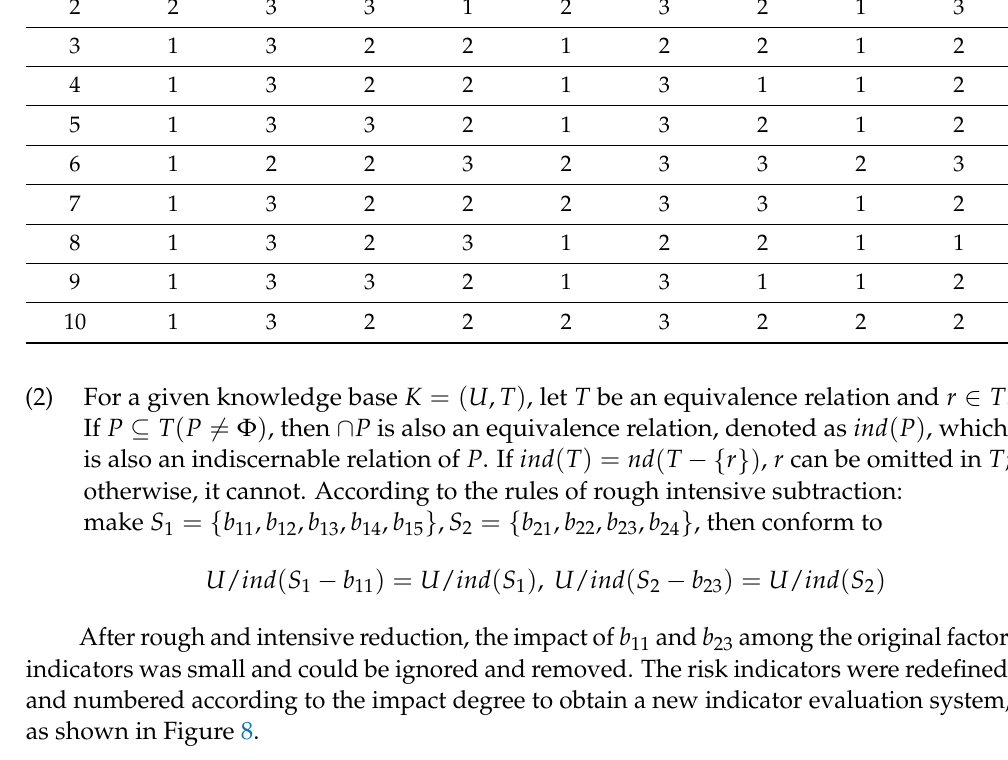
Table 3. Expert scoring of safety risk factors of a steel bracing system. Expert b11 Expert